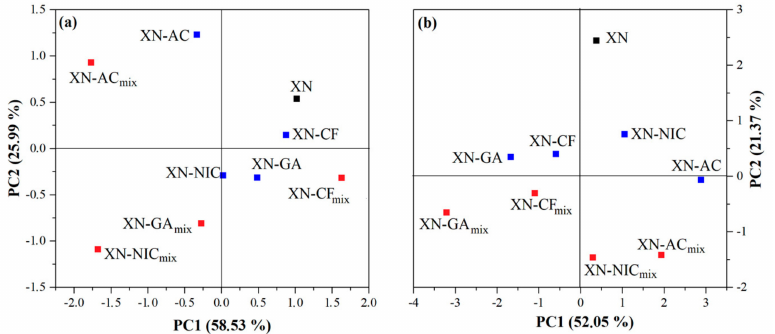
Figure 14. PCA 2D score plots (PC1 vs. PC2). ( a ) The region of 3700–2700 cm − 1 , and ( b ) the region of 1800–1000 cm − 1 (red symbols represent the physical mixtures, blue symbols represent the cocrystals, and black symbols represent